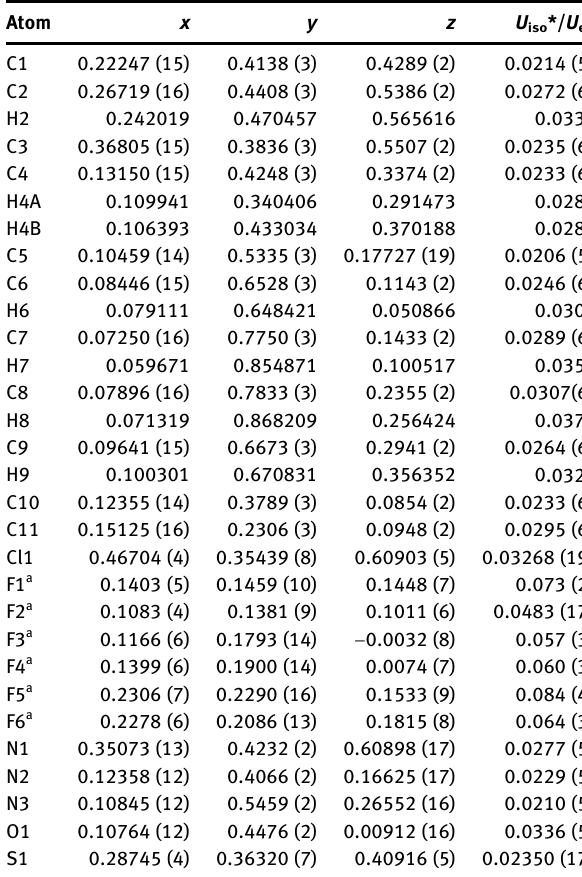
Table  : Fractional atomic coordinates and isotropic or equivalent isotropic displacement parameters (Å 